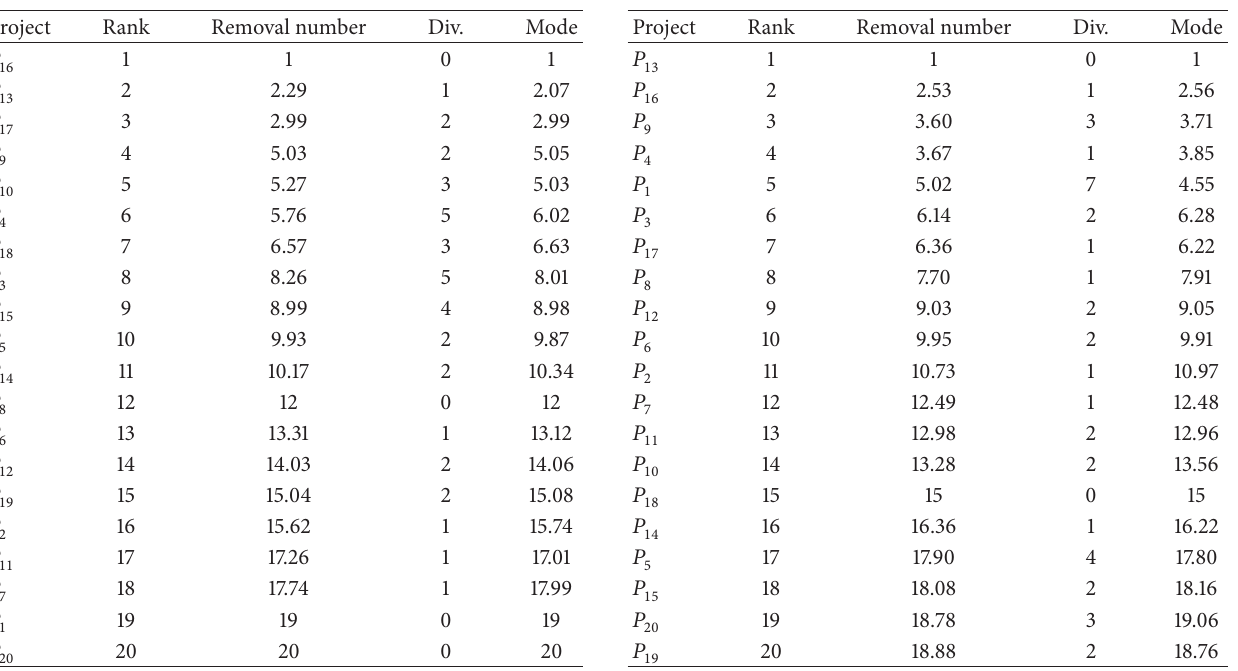
Table 4: Overall rankings of the R&D projects with multidistance using removal number, dispersion, and modal value.